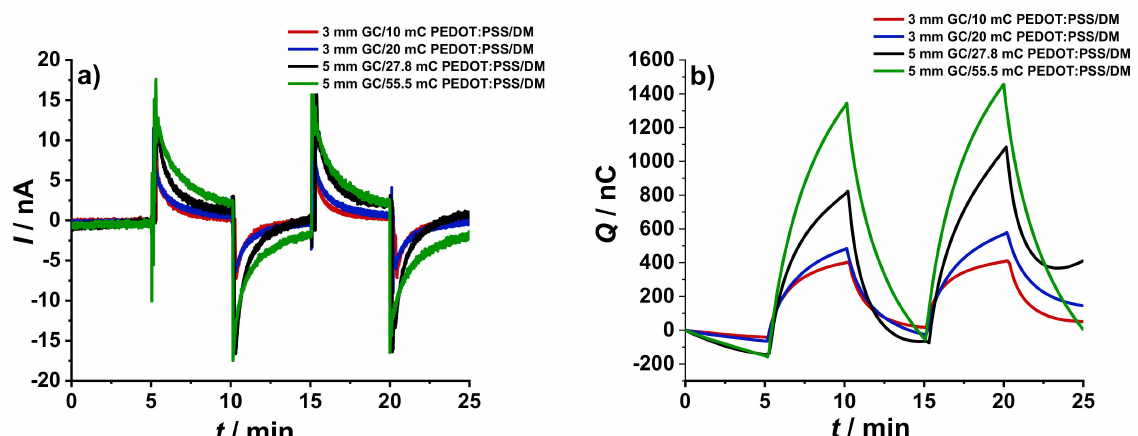
Figure 6. Chronoamperometric ( a ) and chronocoulometric ( b ) response during the addition/dilution experiments using different PEDOT:PSS-based WEs with equivalently thin dummy membrane and a GC/2 mC PEDOT:PSS/50 µ L K + -ISM connected as the RE and GC rod as the CE. The addi- tion/dilution steps correspond to a 5% increase/decrease in K + concentration in a starting solution of 10 − 3 M KCl + 10 − 1 M NaCl as